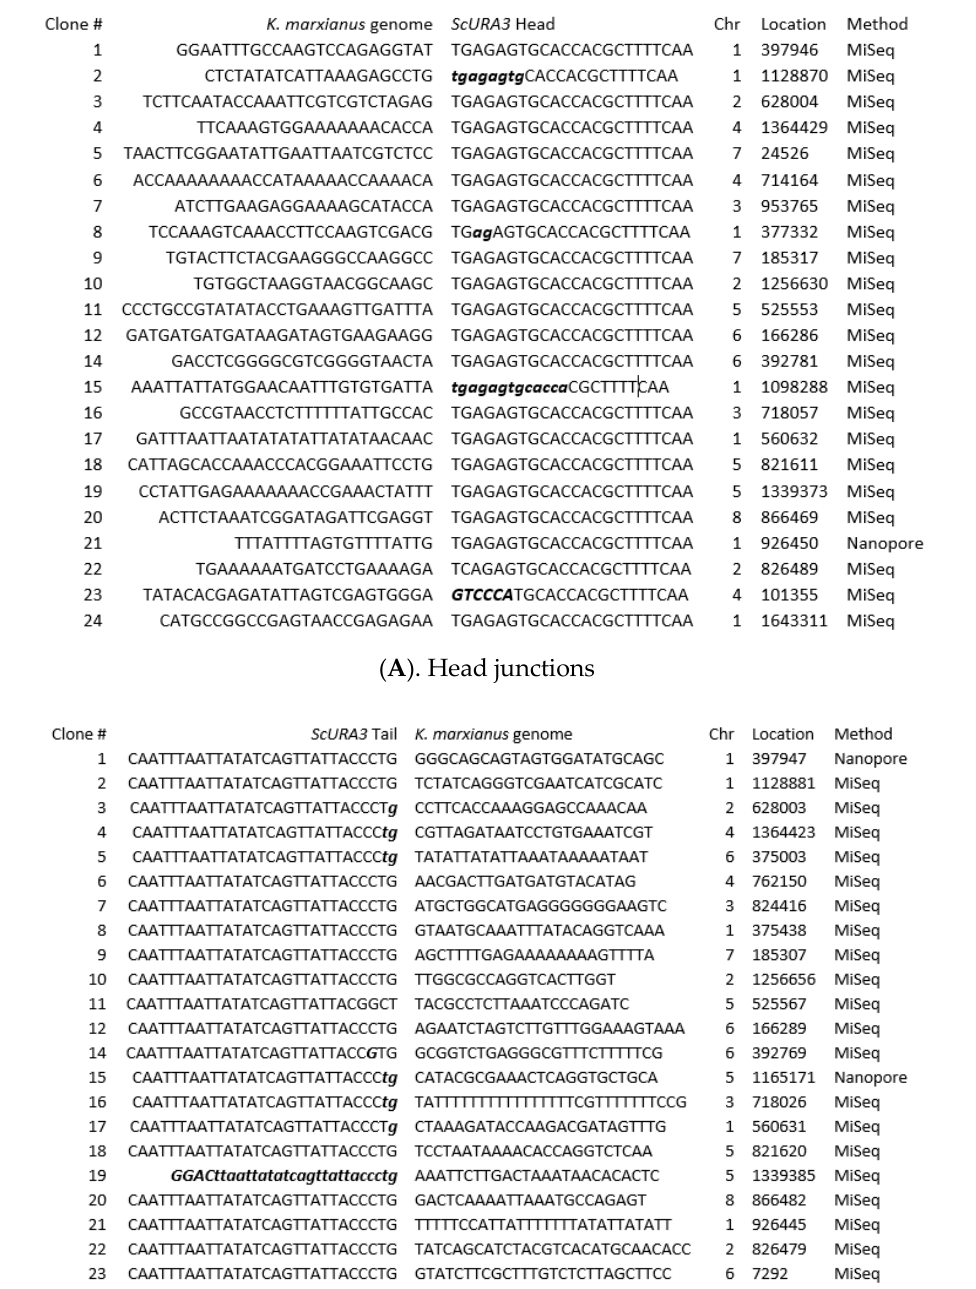
Figure 2. Head and tail junction sequences from Illumina MiSeq reads of the inverse PCR 24-clone libraries constructed as shown in Figure 1. ( A ). Head junctions. ( B ). Tail junctions. Chromosome (Chr) and insertion sites are indicated. Lower case, italicized, bold letters indicate deleted bases. Upper case, italicized, bold letters indicate base substitutions.